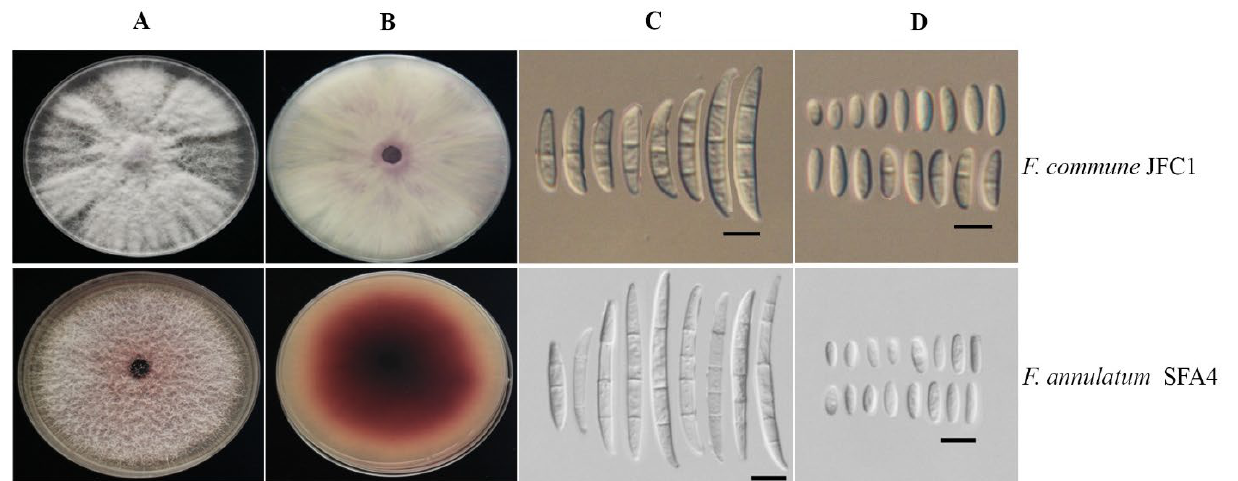
Figure 2. Colony and conidia morphology of F. commune and F. annulatum isolated from symptomatic corms of Crocus sativus. ( A ) Upper view of a colonies on PDA; ( B ) reverse view of colony on PDA; ( C ) Macroconidia; ( D ) Microconidia—scale bars: C – D = 10 μm.